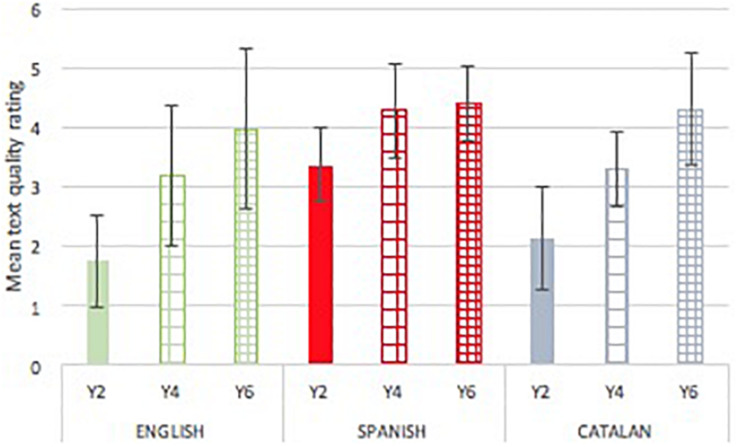
Mean (SD) text quality by language and school grade.